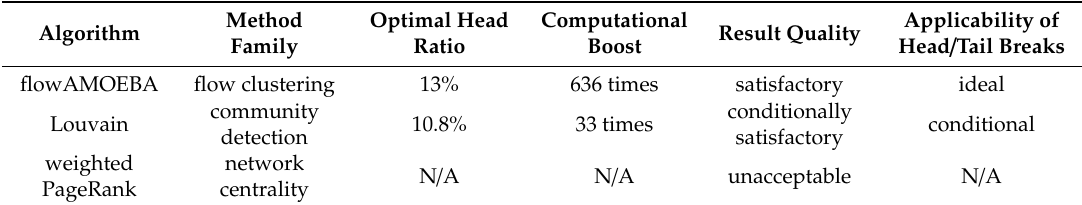
Table 1. Summary of